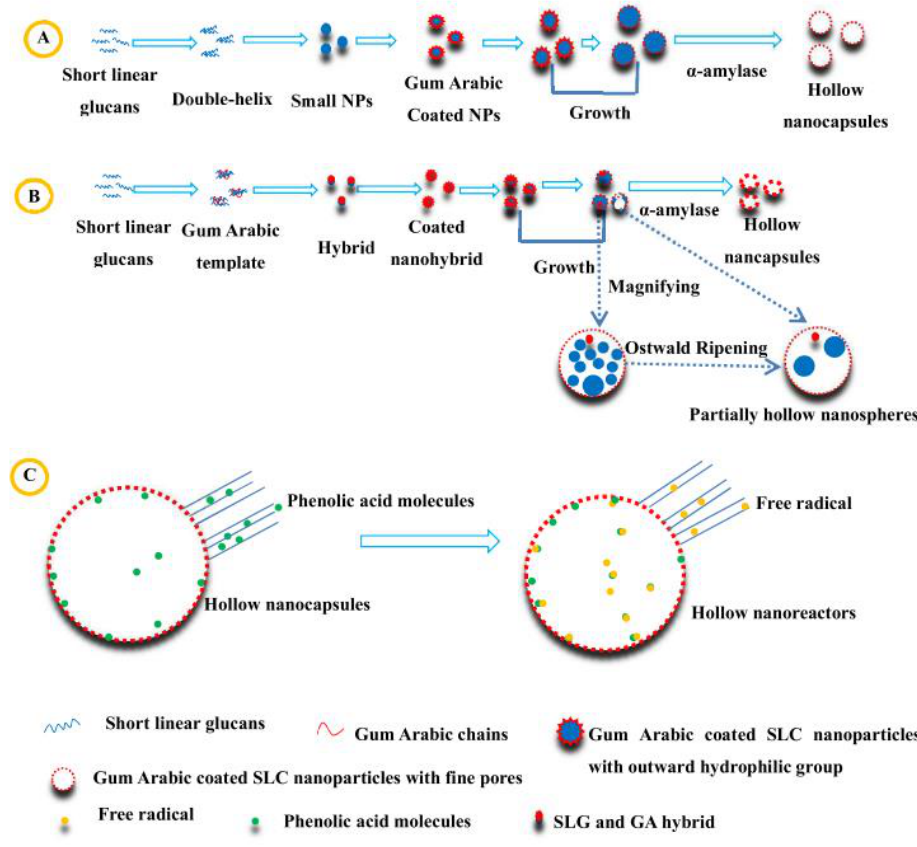
Figure 14. Schematic representation of the nanoengineering method and antioxidant mechanism of ( A ) hollow SLG@GA nanocapsules, and ( B ) in-situ SLG/GA hybrid and ( C ) phenolic acid/ free radicals reaction mechanism in the hollow nanoreactors. Reprinted (adapted) with permission from [40]. Copyright 2023 American Chemical